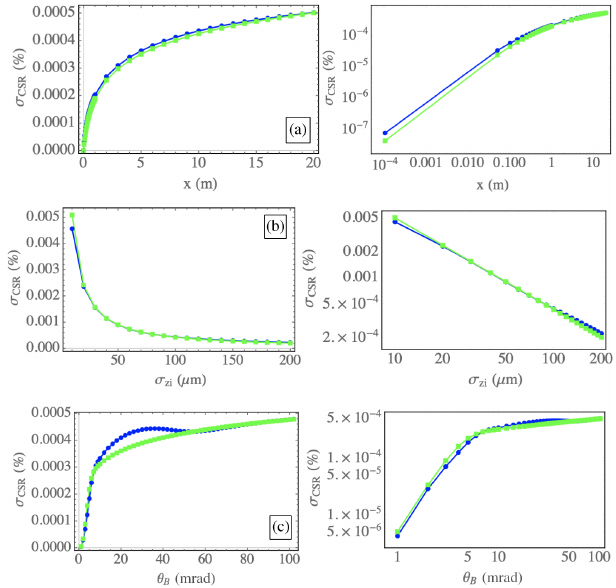
FIG. 6. The CSR rms energy spread of a chirped beam ( σ zi ¼ 100 μ m) traversing the third bend ( L B ¼ 0 . 55 m) of a 4-Bend chicane. The bend angle is varied and therefore the final bunch length out of the bend is as well. Top: The final bunch length (black line) and the modified slippage length (red line) from Eq. (7), the transition occurs at θ T ¼ 0 . 056 rad. Bottom- left: The CSR rms energy spread from ELEGANT (blue), numerical integration of Eqs. (1) and (2) (orange), and Eq. (18) (green). Bottom-right: Log-Log plot of the CSR rms energy spread.